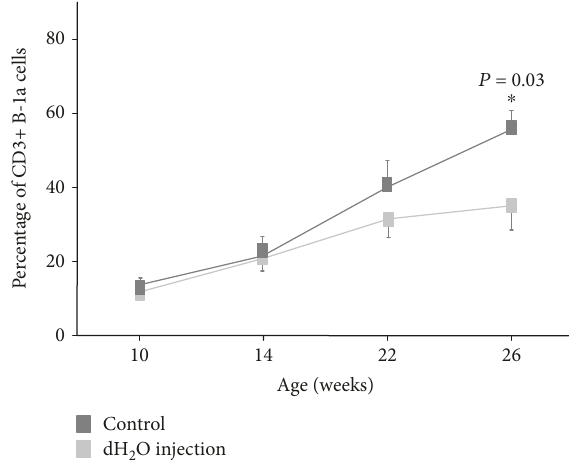
Figure 7: Depletion of CD3+ B-1 cells by repeated intraperitoneal injections of distilled water. Flow cytometric analysis of cells from the peripheral blood by using antibodies against CD3, B220, CD5, and CD23 was used to assess the depletion of CD3+ B-1a cells. The MRL/ lpr mice, into which 1 ml of dH O had been injected 2 weekly from 6 weeks of age (dH O injection; n = 5 ), showed a 2 signi fi cant reduction in the frequency of CD3+ B-1a cells when compared with the control mice (control; n = 8